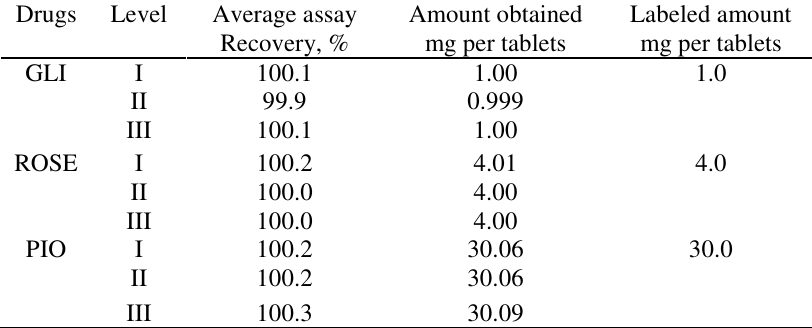
Table 5. Assay of combined dosage form and recovery